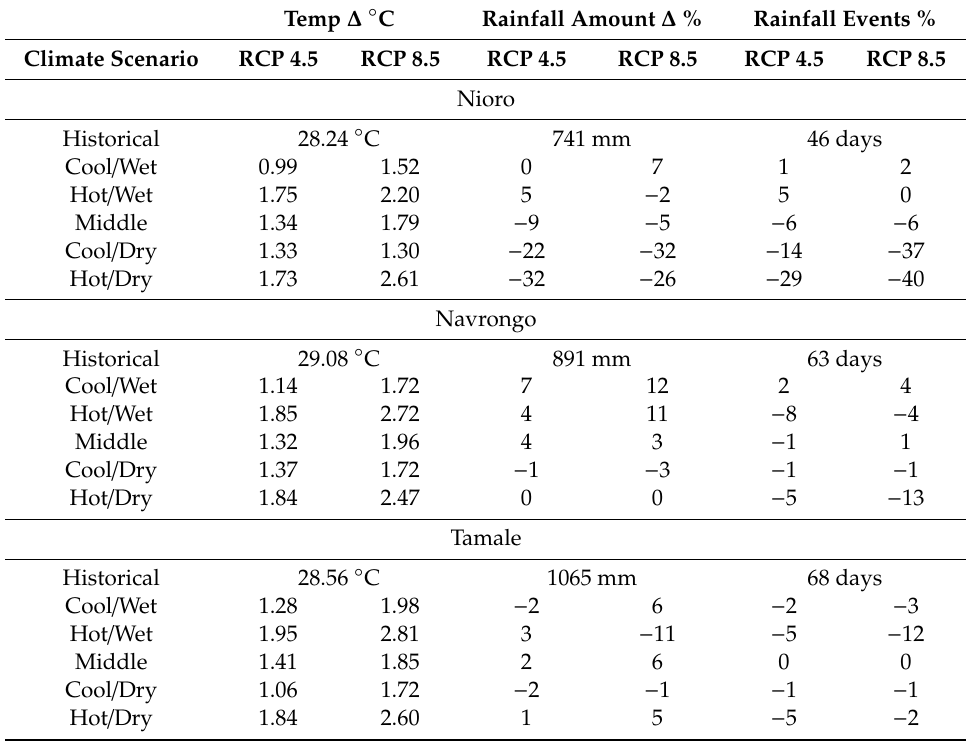
Table 5. Changes in temperature and rainfall parameters under climate change scenarios (2040—2069) relative to historical (1980–2009) climate at Nioro (Senegal) and Navrongo and Tamale